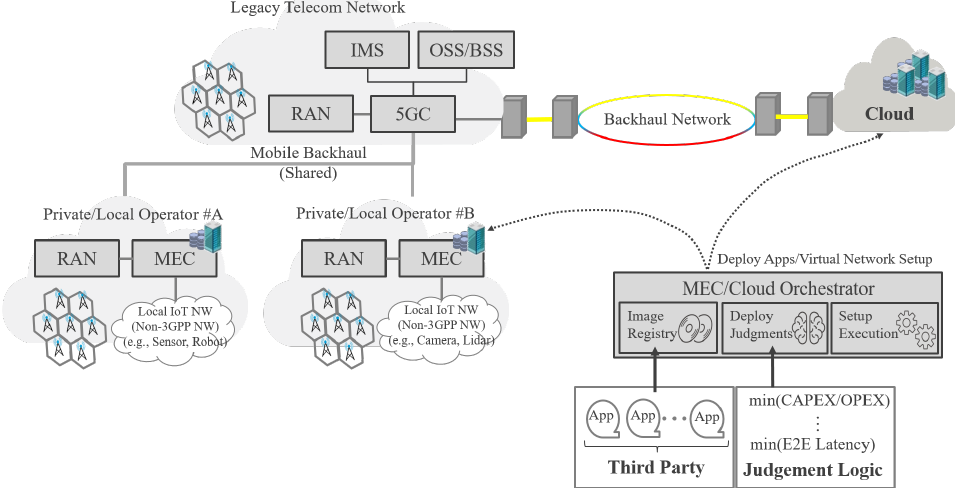
Figure 3. Illustration of the system architecture of an MEC/Cloud Orchestrator for a Private/Local Telecom Operator and Cloud